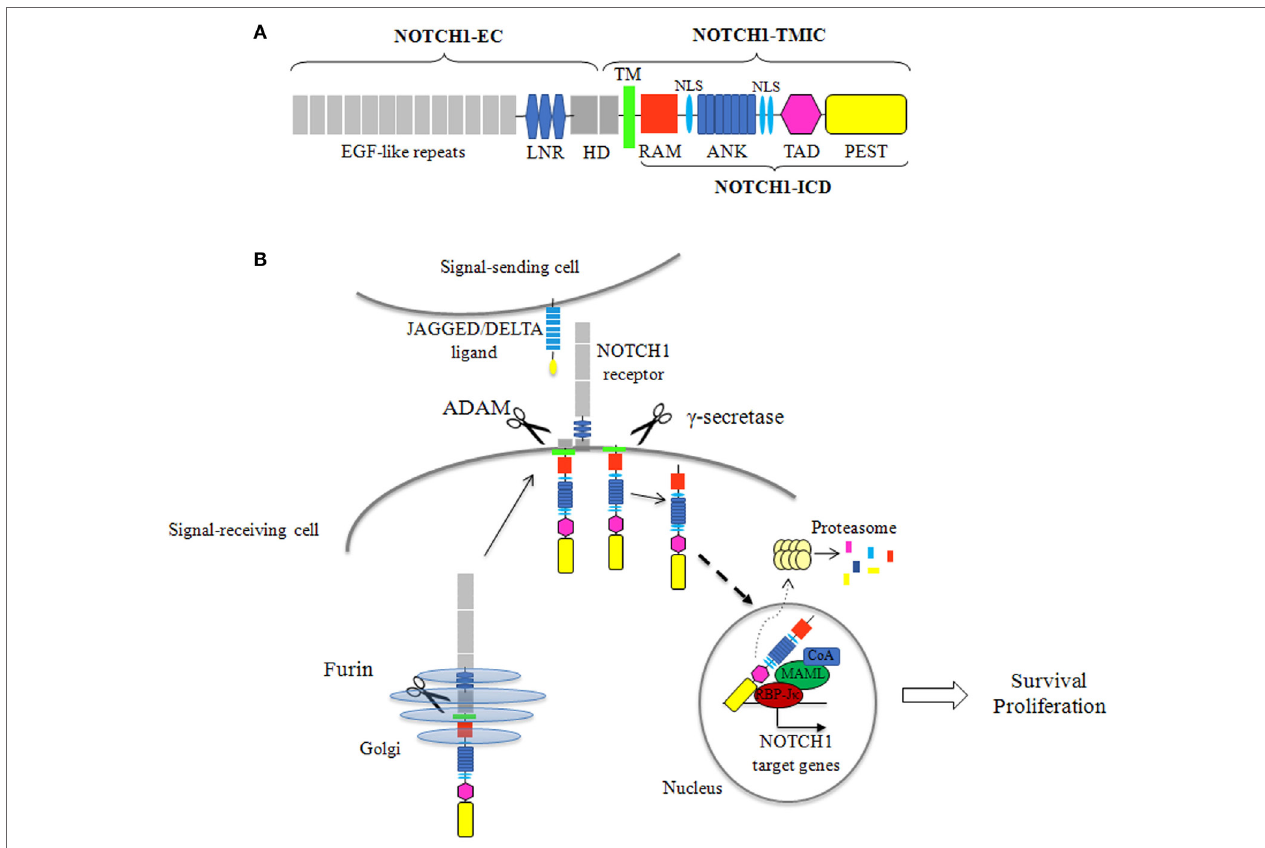
FigURe 1 | NOTCH1 protein structure and signaling activation. (A) The mature NOTCH1 receptor is a heterodimer composed of an extracellular subunit (NOTCH1-EC) and a transmembrane and intracellular subunit (NOTCH1-TMIC). The NOTCH1-EC includes epidermal growth factor (EGF)-like repeats, involved in ligand binding, three LIN-12/NOTCH repeats (LNR), which prevent receptor activation in the absence of ligands, and the heterodimerization domain (HD) involved in non-covalent interactions between the NOTCH1-EC and NOTCH1-TMIC. The NOTCH1-TMIC consists of the transmembrane domain (TM) and the intracellular domain (ICD) (NOTCH1-ICD). NOTCH1-ICD comprises an RBPJ-associated molecule (RAM) domain, seven ankyrin (ANK) repeats, nuclear localization signals (NLS), a transactivation domain (TAD), and a PEST domain, which is involved in proteasomal degradation of active NOTCH1-ICD. (B) Newly synthesized NOTCH1 precursor is cleaved by a furin-like convertase (Furin) in the Golgi apparatus to generate the mature receptor. NOTCH1 signaling initiates when a JAGGED or DELTA ligand expressed on a signal sending cell interacts with NOTCH1 on a signal receiving cell. This interaction triggers two sequential cleavages of NOTCH1: the first, by an a disintegrin and metalloproteinase (ADAM) metalloproteinase, generates the substrate for the second cleavage by γ -secretase, which releases the active NOTCH1-ICD. NOTCH1-ICD translocates to the nucleus where it forms a transcriptional activation complex by interacting with the transcription factor CSL/RBP-Jk, mastermind-like proteins, and others coactivators (CoA), leading to the expression of NOTCH1 target genes. In physiological conditions, NOTCH1 signal attenuation is mediated by ubiquitination and proteasomal degradation of NOTCH1-ICD.